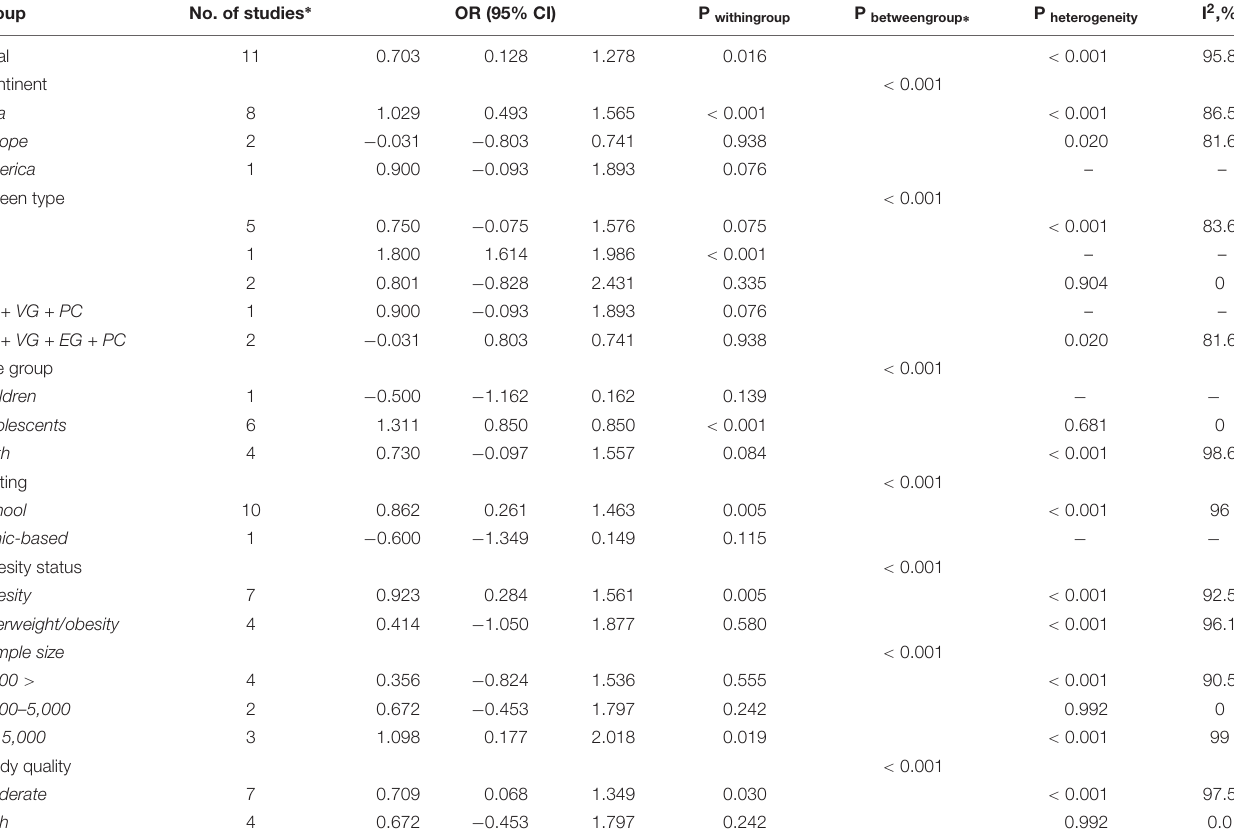
TABLE 4 | Subgroup analysis for the comparison of BMI among highest vs. lowest screen-user children and adolescents. Group No. of studies ∗ OR (95%